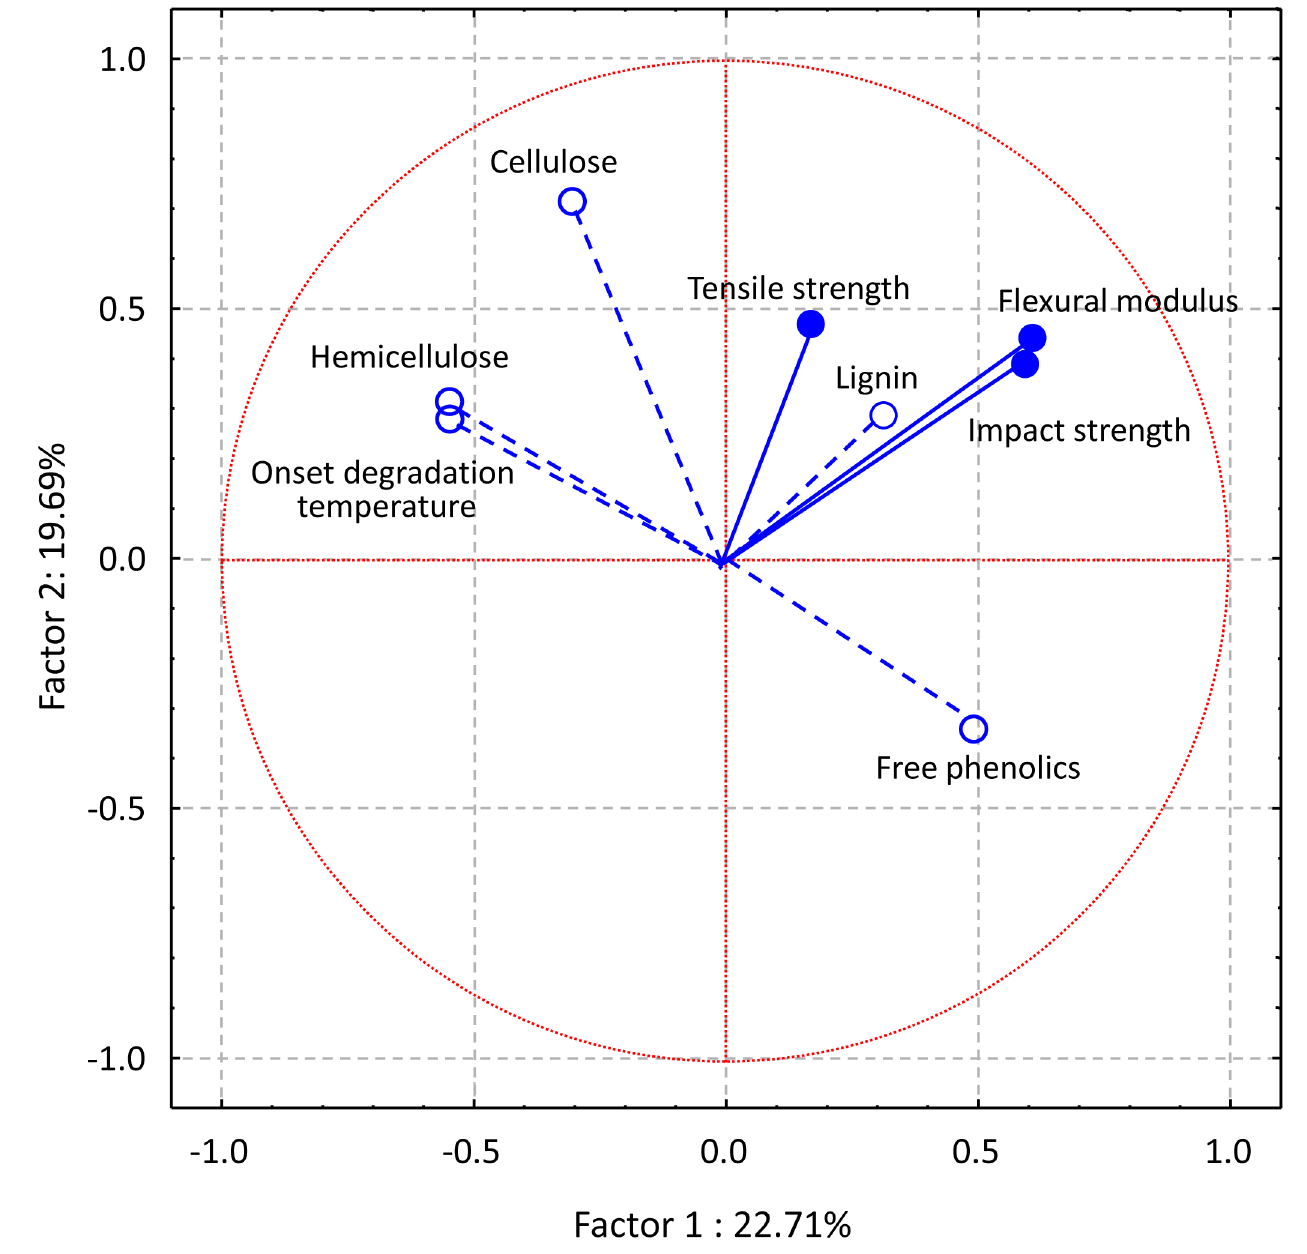
Fig 1. Projection of the physico-chemical variables of soybean stem fibers and soybean stem fiber/polypropylene (SS/PP) composite materials. Factors 1x2 explained 42.4% of the variability.